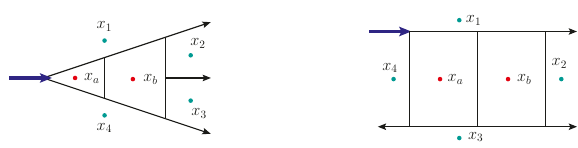
Figure 7. Master graphs for two-loop tr( φ 2 ) form factor.